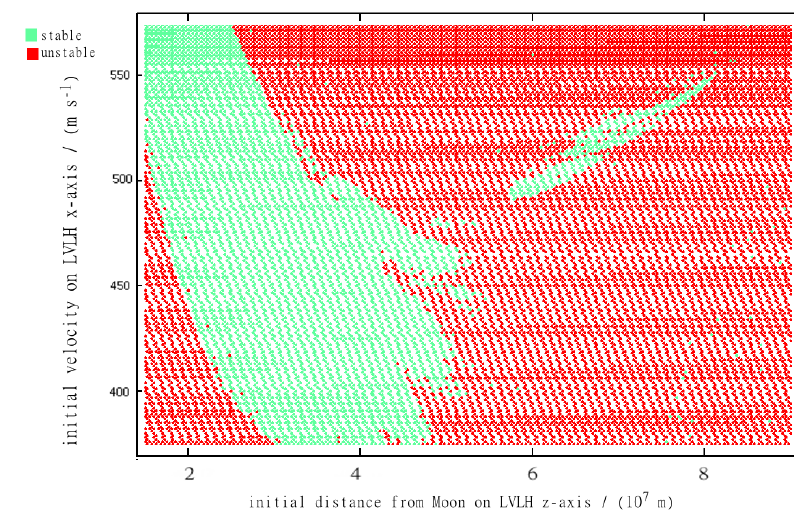
Figure 11. Superposition of the stable states from Figure 10 and the corresponding unstable initial states. Green (light shading) represents stable states, red (dark shading) represents unstable states. See also Figures 14 or 20 for more comprehensive data